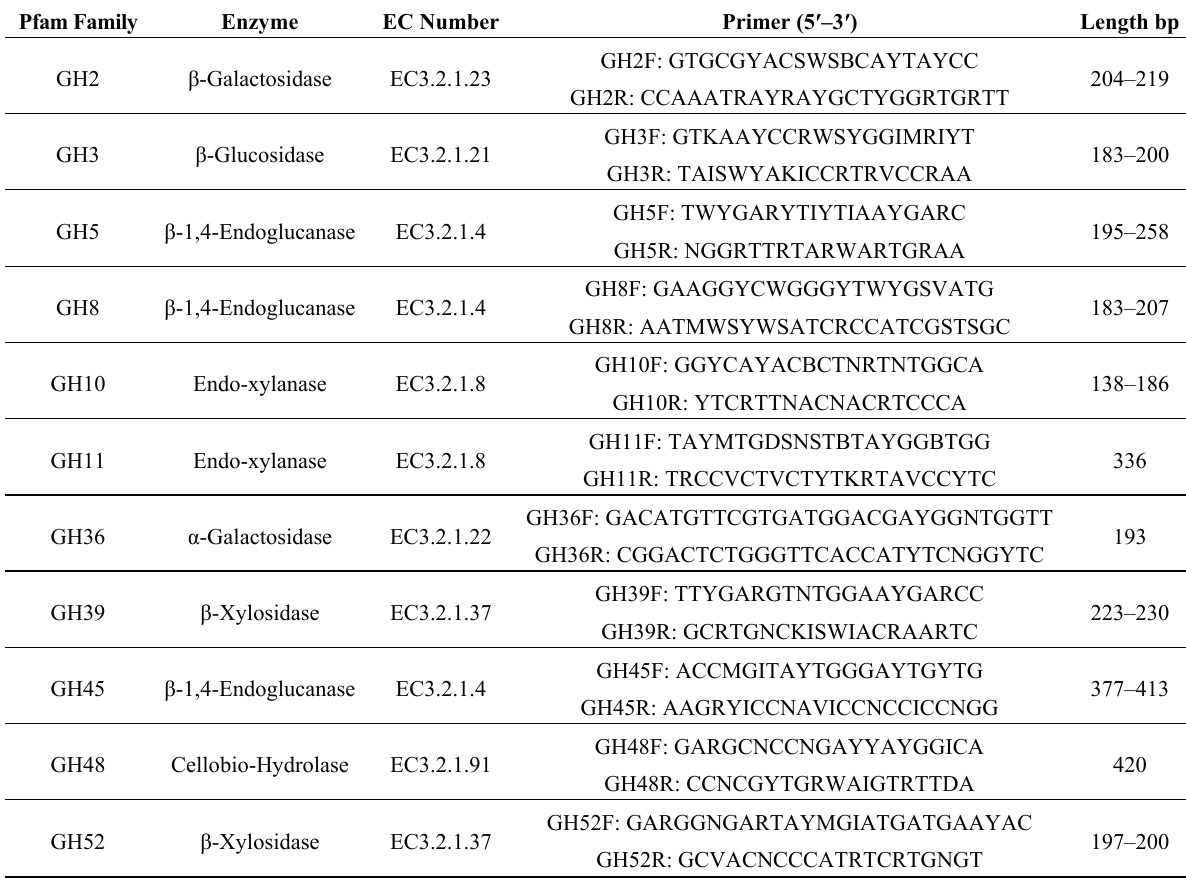
Table 1. Degenerate primers designed to amplify cellulase and hemicellulase gene fragments.